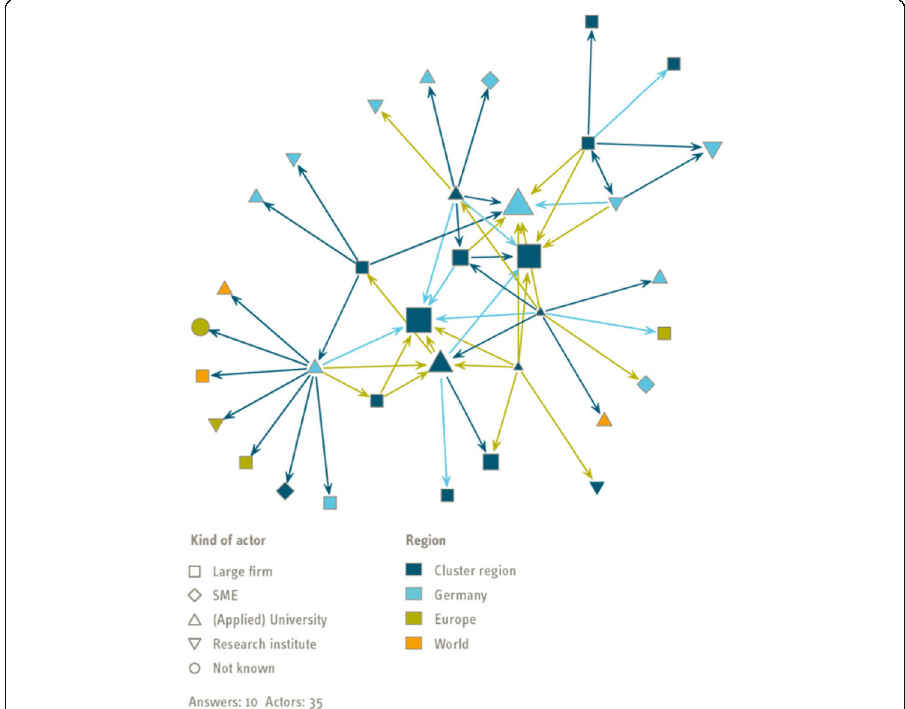
Fig. 6 Cooperation network of the cluster Forum Organic Electronics. Source: Accompanying evaluation of the LECC; written survey of the LECC-funded organisations in 2013. – Comments: The size of the nodes is proportional to the frequency with which an actor is named as the most important cooperation partner. Arrows pointing in the direction of the named cooperation partner; dark blue = not initiated or intensified by the LECC, light blue = intensified by the LECC (existed before 2007), light green = initiated by the LECC (did not exist before